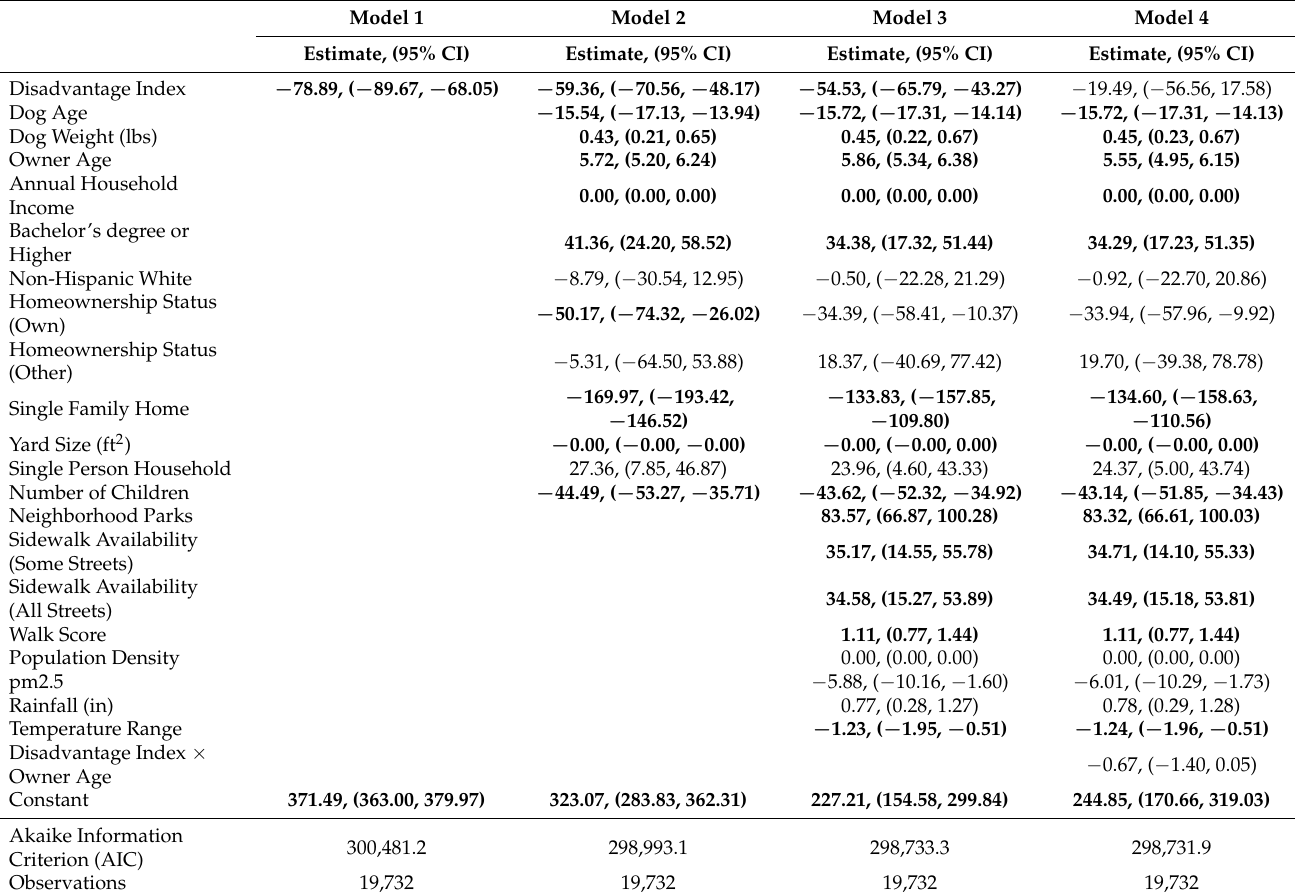
Table 3. Estimated associations between neighborhood disadvantage and dog walking. Dog Aging Project,